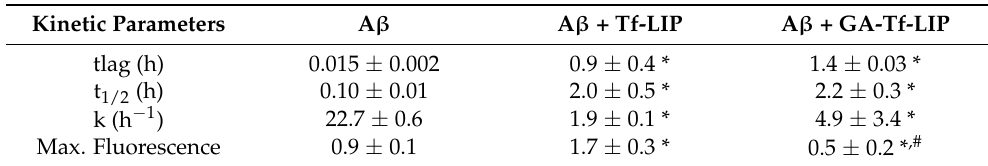
Figure 6. Normalized ThT fluorescence of A β 1-42 (orange data) as a function of time (h) upon incuba- tion with GA (blue data), Tf-functionalized liposomes (green data), and GA-loaded Tf-functionalized liposomes (pink data). Table 3. Kinetic parameters were calculated by fitting Equations (6) and (7) to the ThT data. * Indicates a statistical difference compared to A β ( p < 0.05). # Indicates a statistical difference between unloaded and GA-loaded Tf-functionalized liposomes ( p <